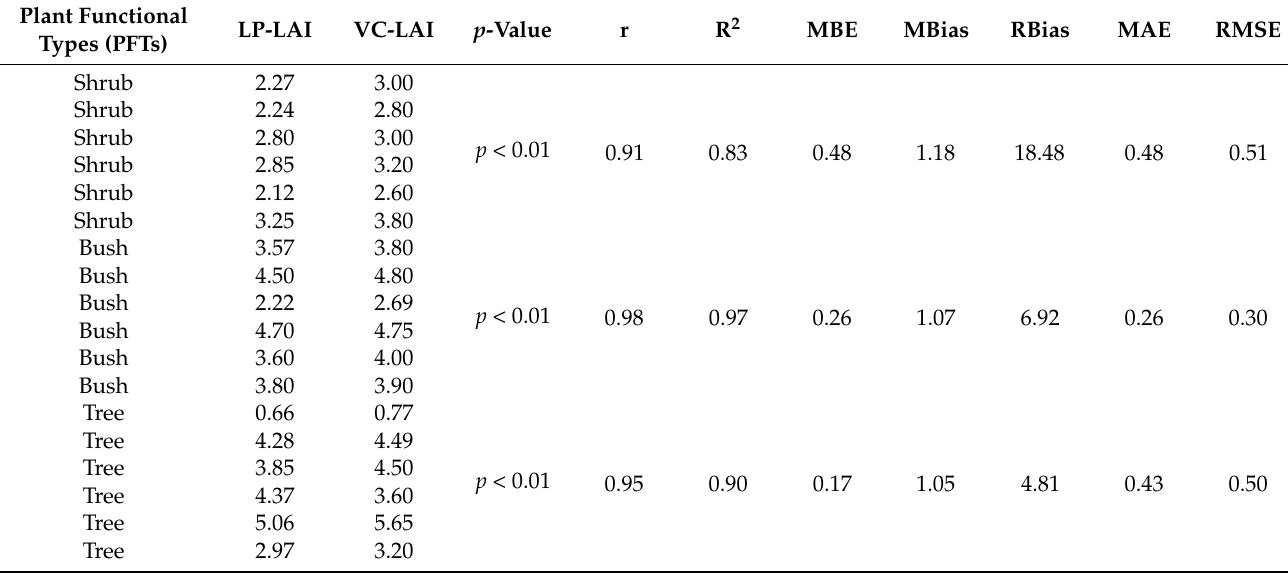
Table 4. Results of LP 100 validation through the VitiCanopy (VC) application.